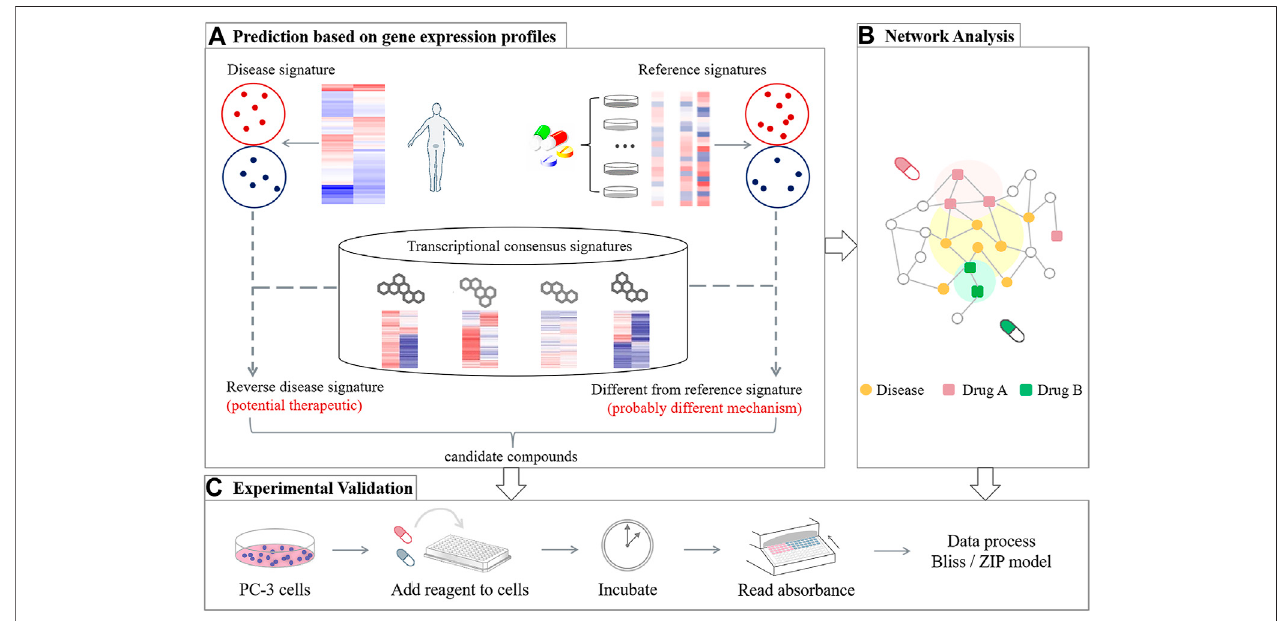
FIGURE 1 | Overview of the design strategy proposed for generating Prostate cancer-speci fi c drug combinations, including three main frameworks: (A) Transcriptomics-based ranking, (B) network-based assessment, and (C) experimental validation.